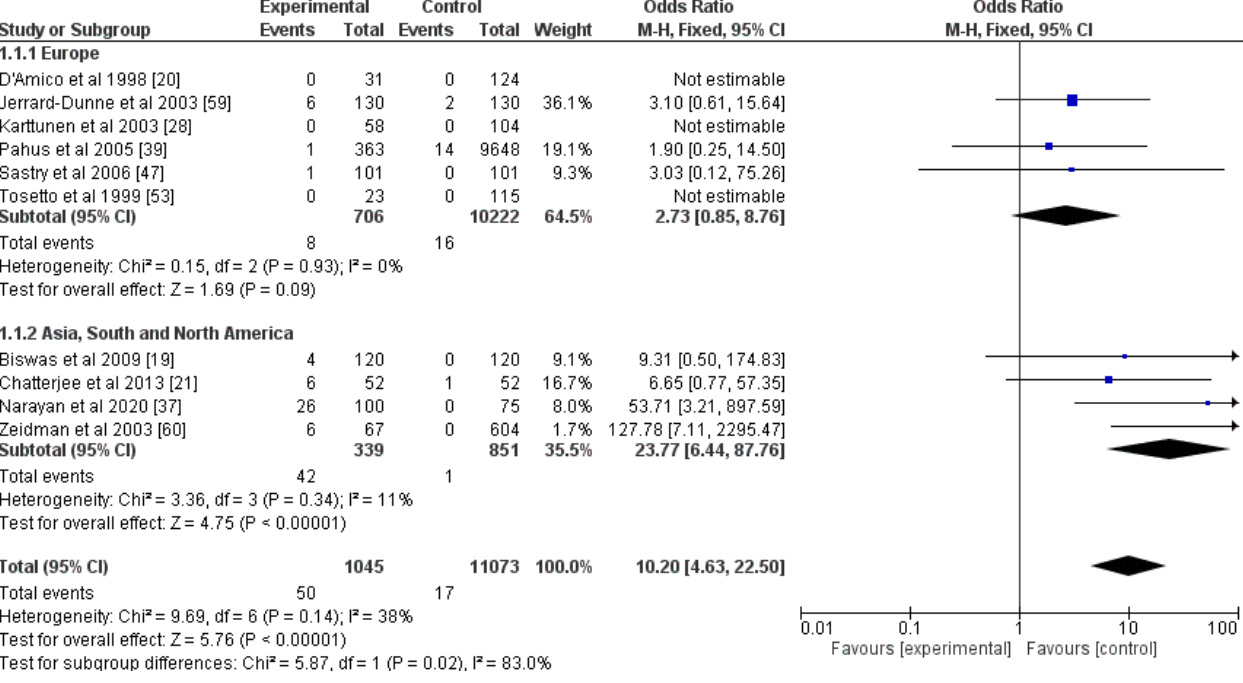
Figure 4. Forest plot for protein C and subgroup analysis based on geographic location of the study. Blue squares indicate odds ratios. Black rhombi indicate overall effect. Vertical line indicates null effect, and horizontal lines indicate values of odds